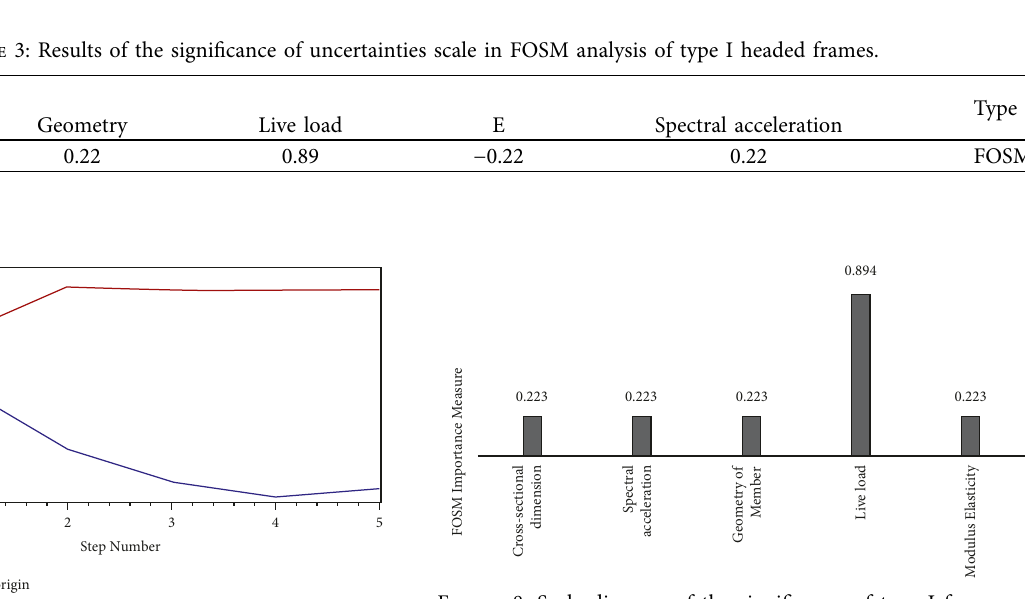
Figure 8: Scale diagram of the significance of type I frame un- certainties in the FOSM